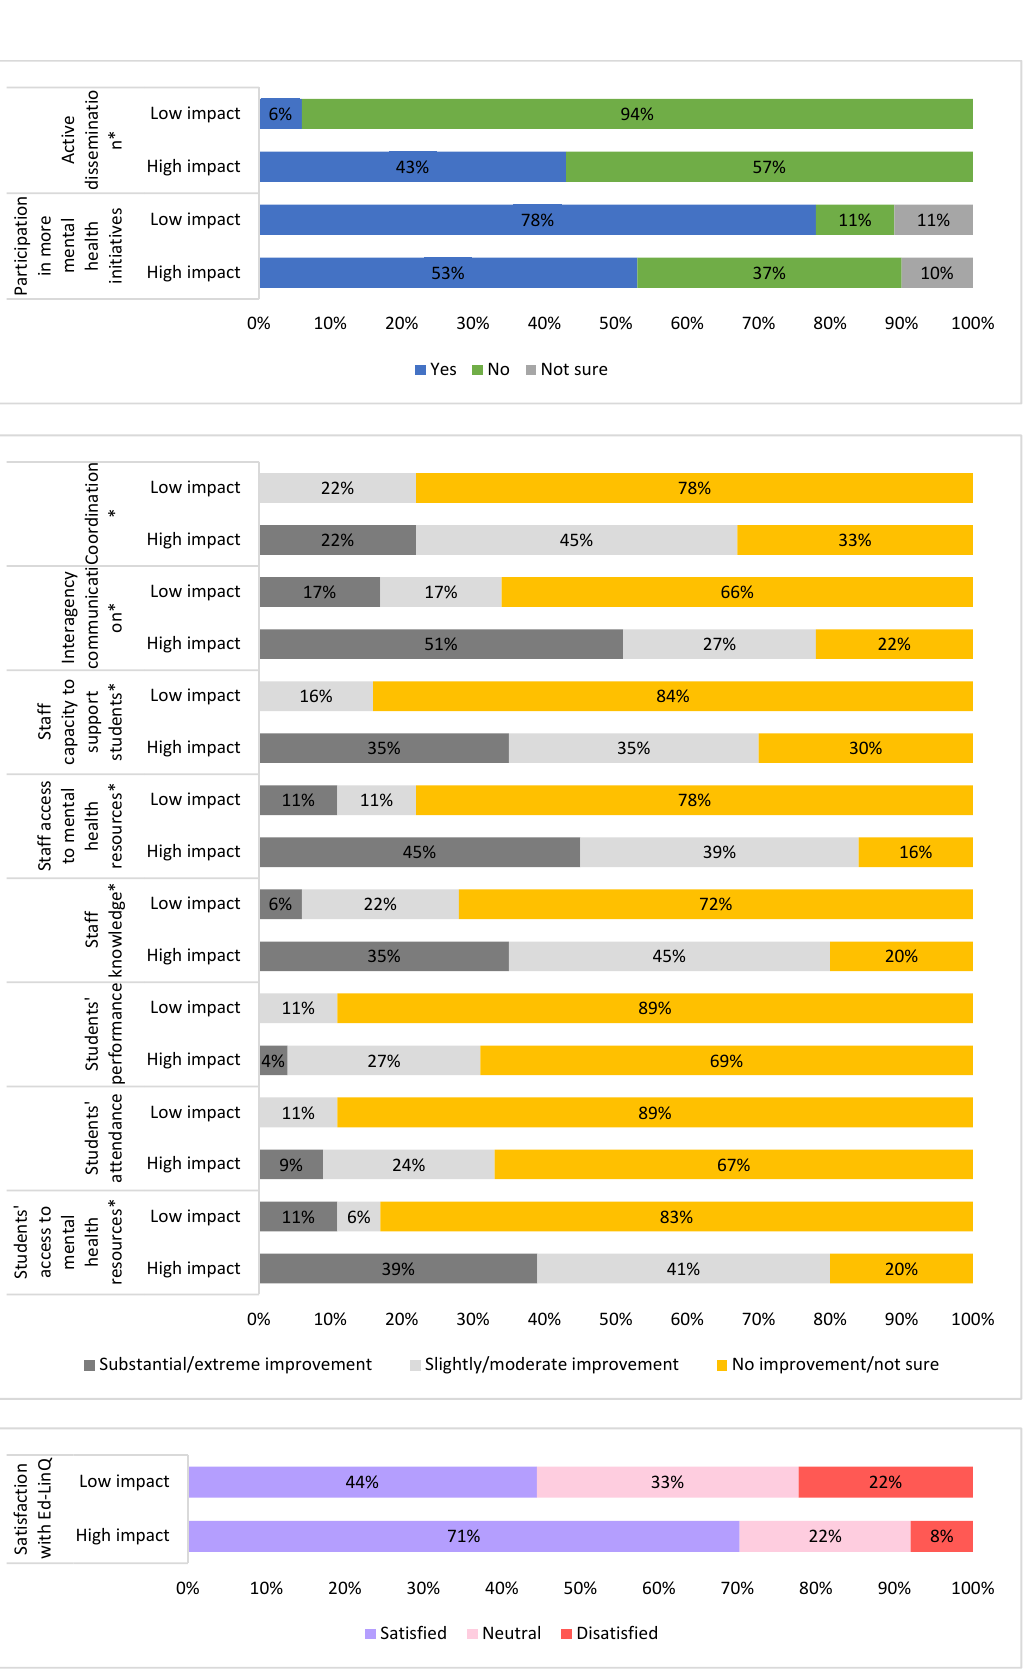
Figure 3. Perceptions of respondents to Survey 1 associated with the impact level of the Ed-LinQ initiative in schools (% of schools, n = 118). * statistically significant